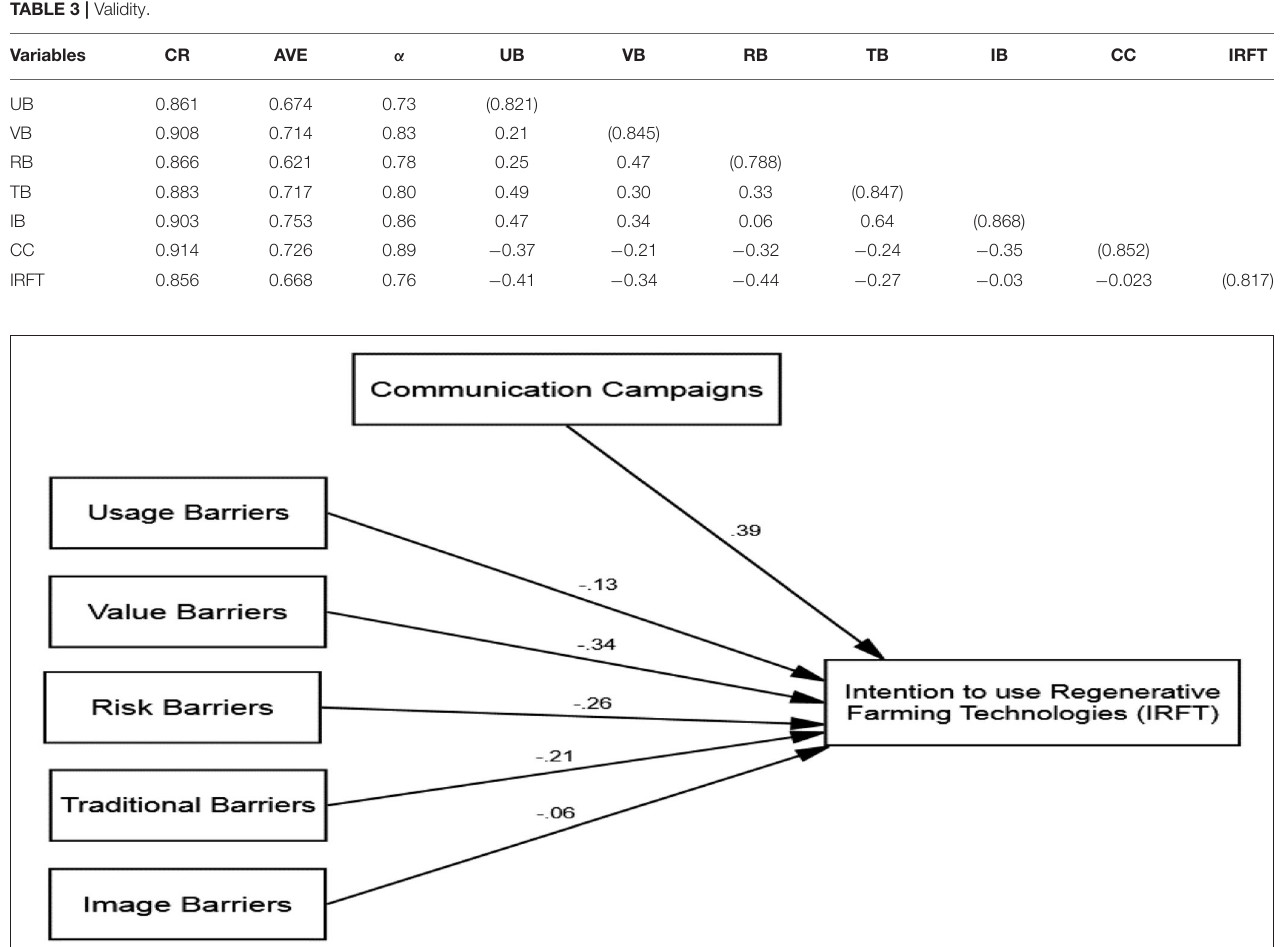
FIGURE 3 | Structural model (AMOS